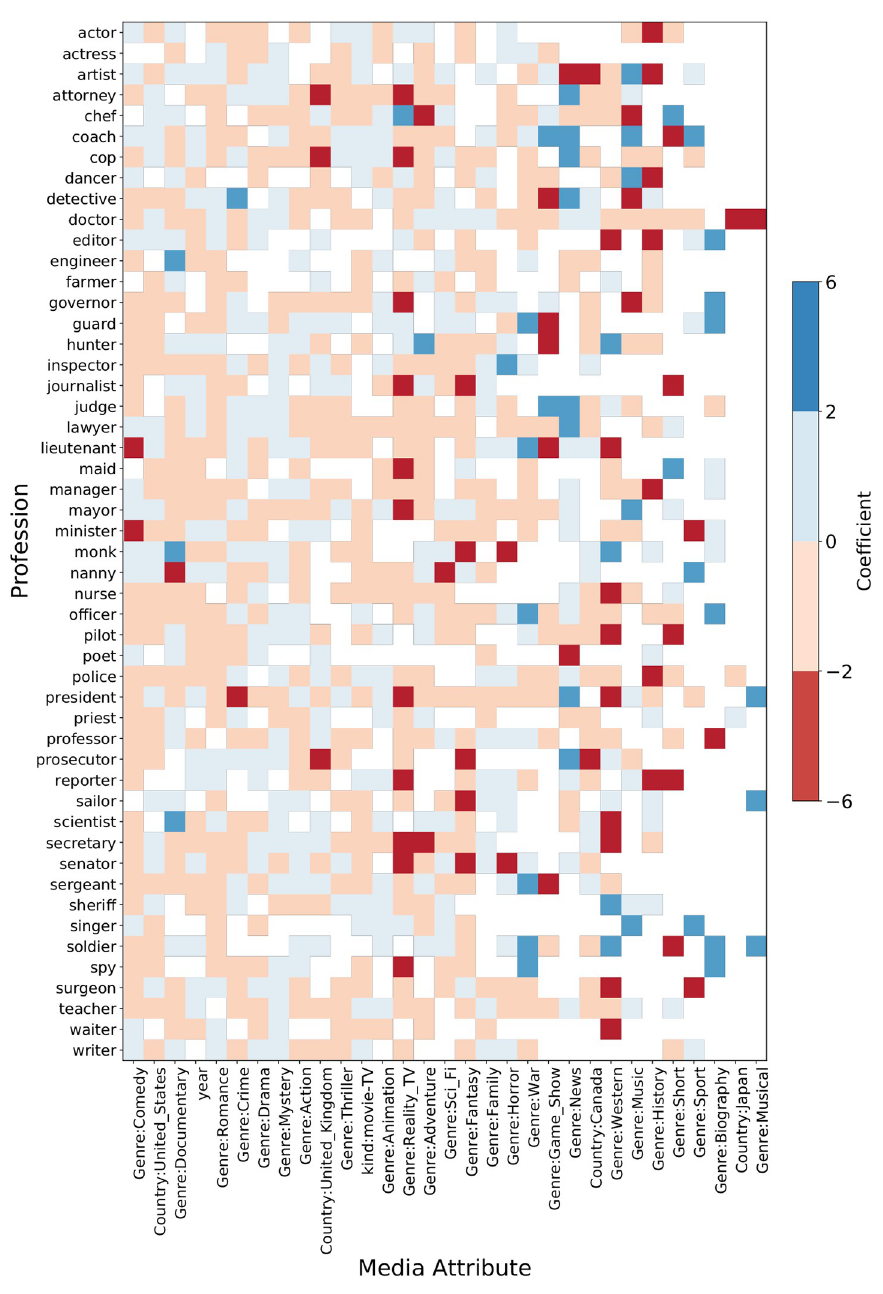
Fig 13. Heatmap of coefficient values of media attributes in predicting profession frequency. The color denotes the sign of the coefficient (blue = +, red = − ) and the intensity of the color is proportional to the magnitude of the coefficient. The blank cells indicate that the media attribute is not a significant predictor for the frequency of the corresponding profession.